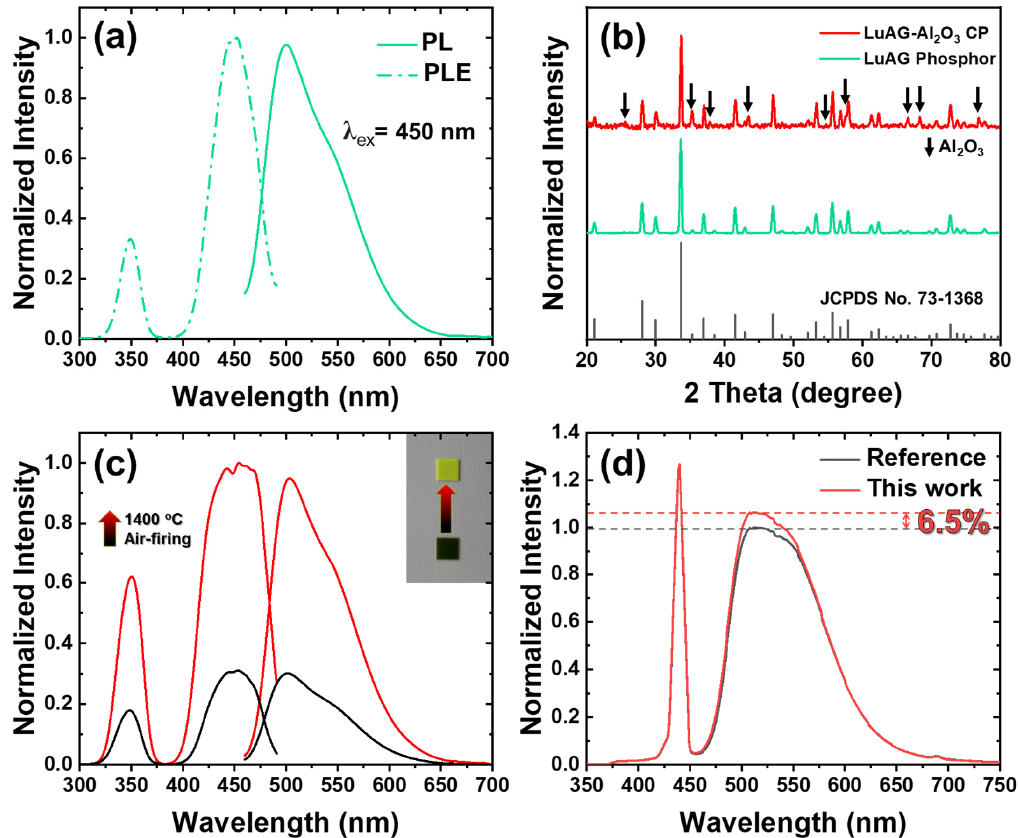
Figure 4. ( a ) PL and PLE of phosphor powder; ( b ) XRD patterns of LuAG:Ce 3+ phosphor powder and LuAG-Al 2 O 3 ceramic phosphor; ( c ) PL and PLE before and after carburization removal of specimen; ( d ) EL spectra with comparative specimens.